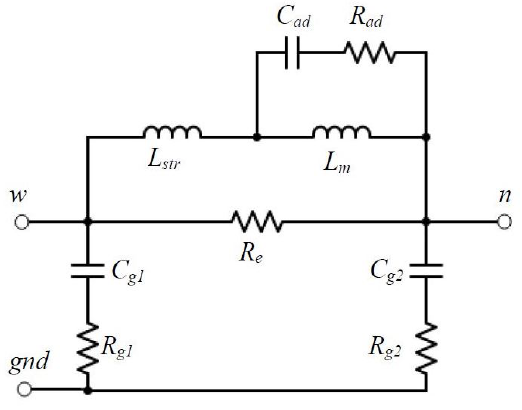
Figure 15. HF phase circuit proposed in